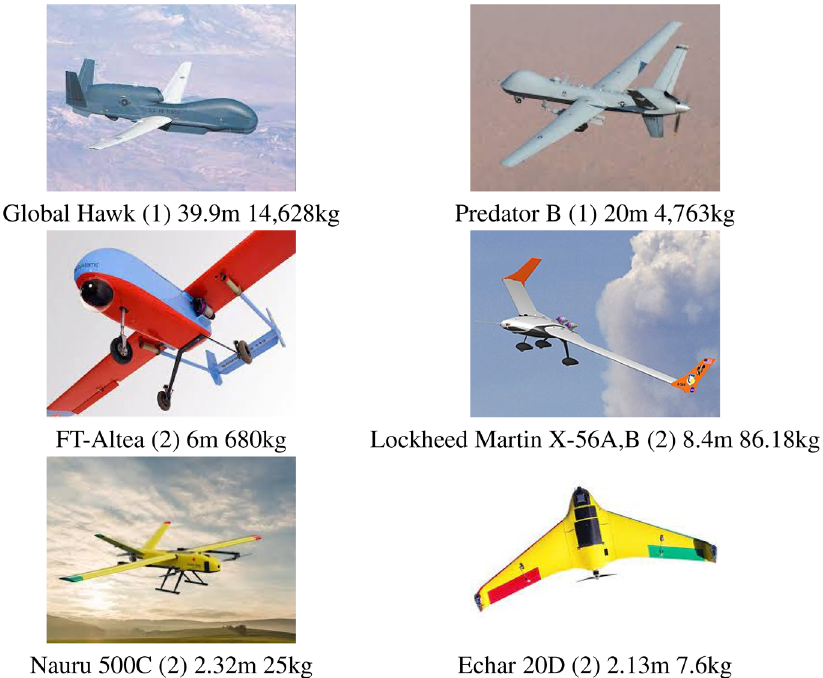
Figure 1. Main fixed wing UAV systems in classes (1) big and (2)